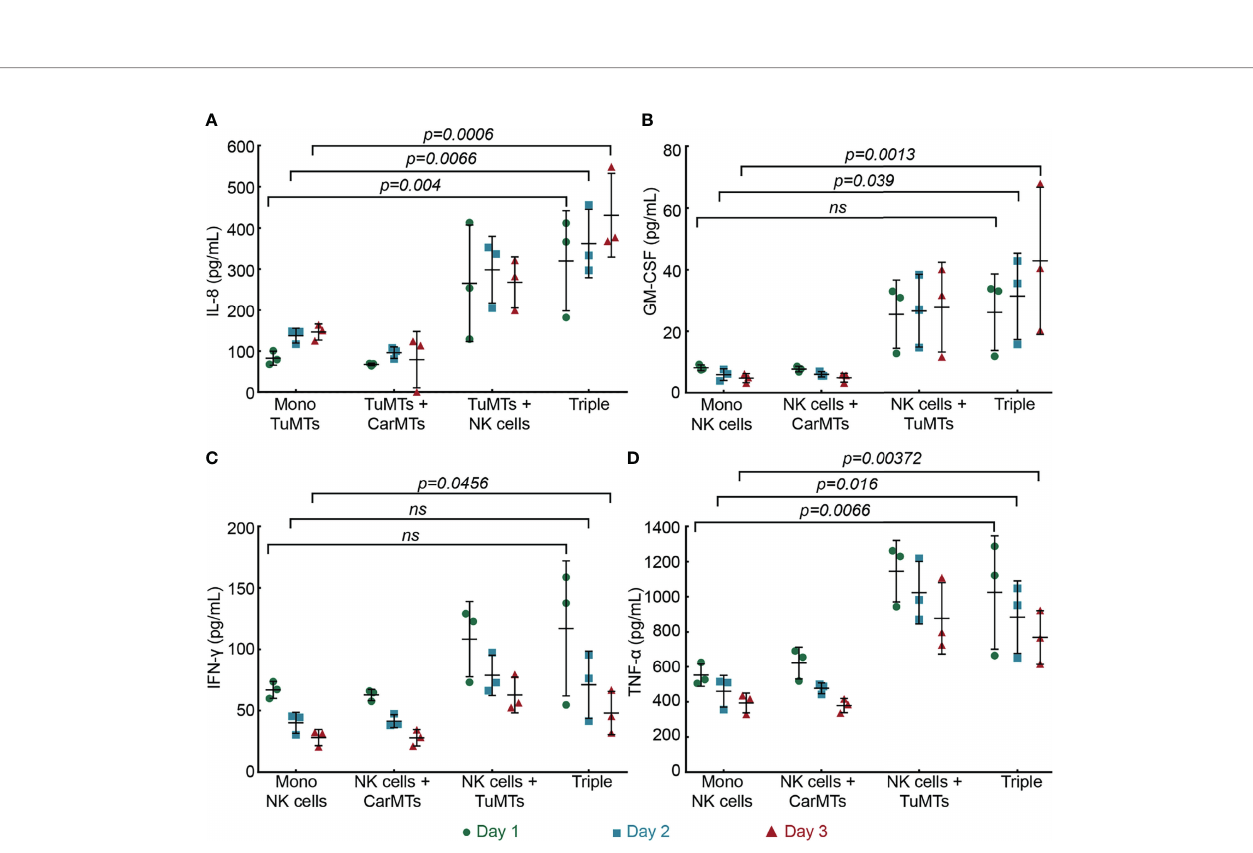
FIGURE 5 | Quanti fi cation of the chemokines/cytokines (A) IL-8, (B) GM-CSF, (C) IFN- g , and (D) TNF- a in the supernatant of different cell culture conditions over a 3-day experimental period (n = 3) (Mono, mono-culture; Triple, triple culture) (ns: not signi fi cant). Detailed statistical comparisons between conditions are shown in Figure S8